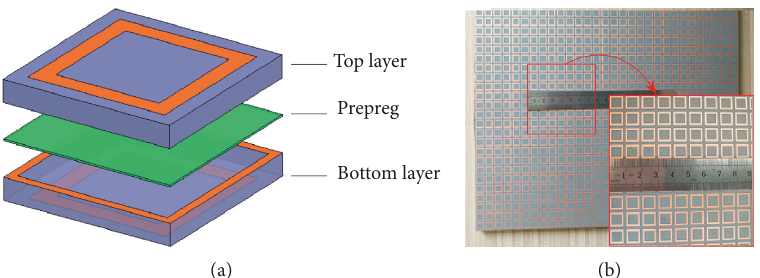
Figure 12: Configuration of the band-pass FSS with steep falling edge. (a) Exploded view of the FSS. (b) Photograph of the fabricated prototype.